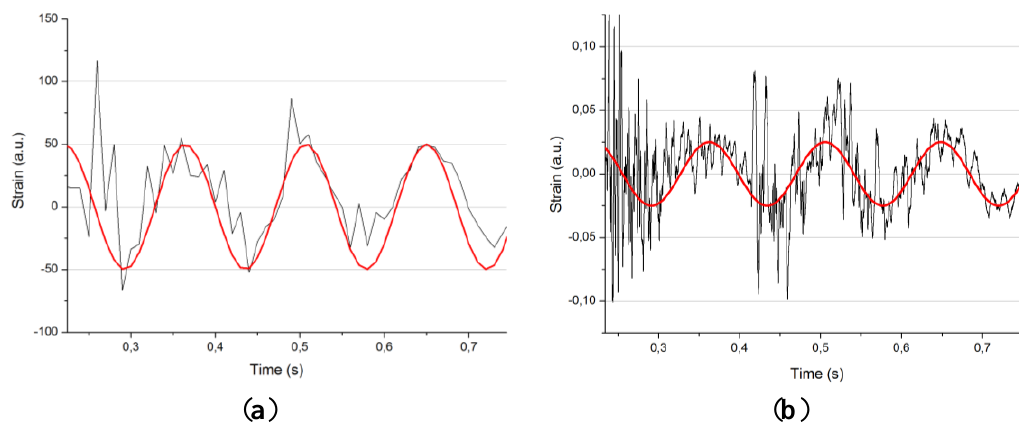
Figure 11. Strain value graph recorded at 100 Hz by means of the MicronOptics interrogator ( a ) and data for a same location and energy impact obtained with a 20 KHz interrogator ( b ). In red there is a sinusoidal pattern of 7 Hz to serve as a help when identifying the fundamental frequency of the studied